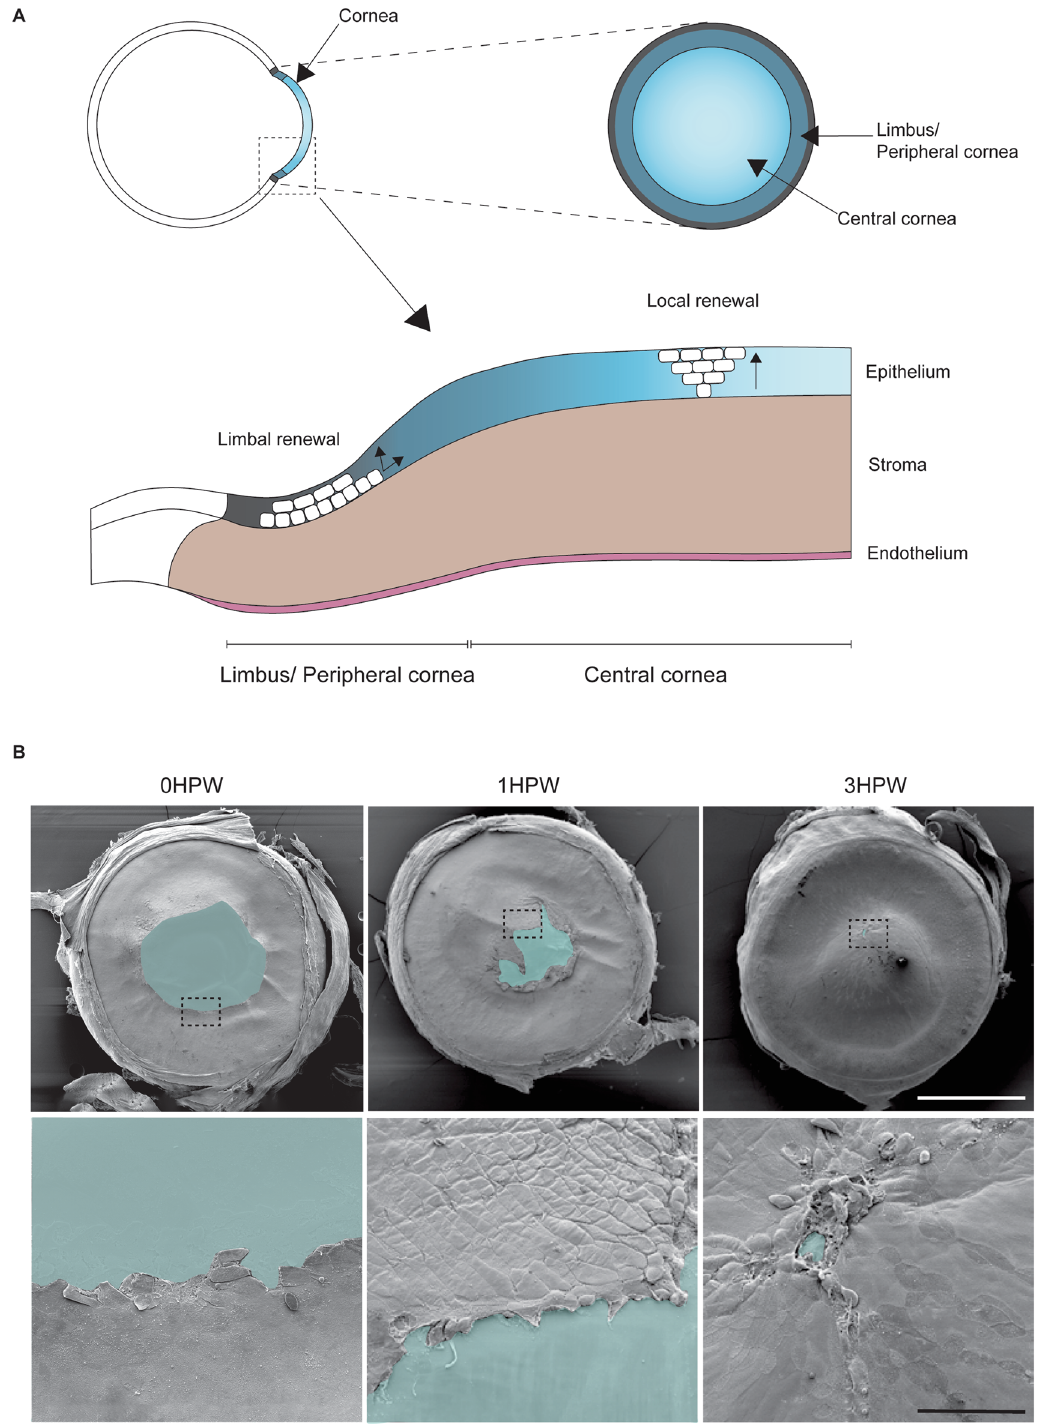
Figure 1. Overview of the cornea and the early steps of corneal wound healing in zebrafish. ( A ) Schematic presentation of the corneal regions, cell compartments, and epithelial renewal. ( B ) Scanning electron microscopy images display clearly the corneal epithelial wound at 0, 1, and 3 h after abrasion. Upper panel: overview of the eyes, blue color marks the wounded area. Lower panel: close up on wound border corresponding to the dashed line boxes from upper row. Three hours after abrasion, the epithelial wound is about to be completely closed. Scale bars: 500 µm upper panel, 50 µm lower panel. HPW: hours